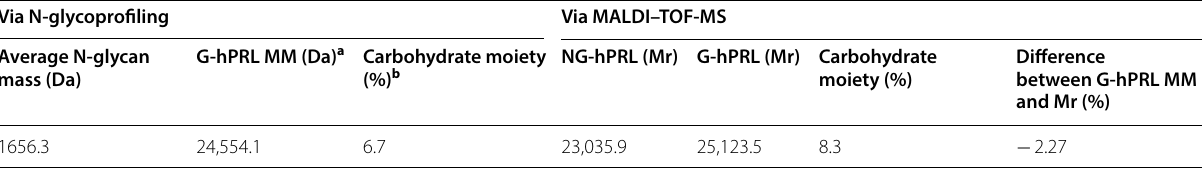
Table 3 Comparisons between the molecular masses of G-hPRL of different origins, determined by MALDI– TOF-MS (Mr) and by N-glycoprofiling (MM)